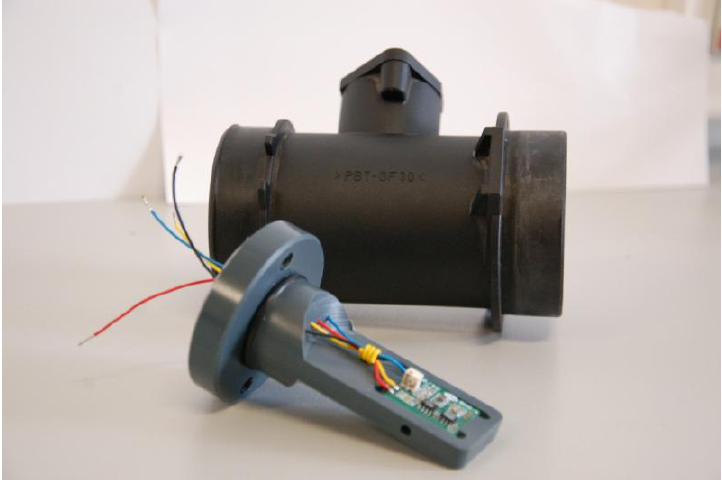
Figure 7. Picture of the final demonstrator of the air flow meter and the automobile engine inlet tube (black tube) in which it is mounted.